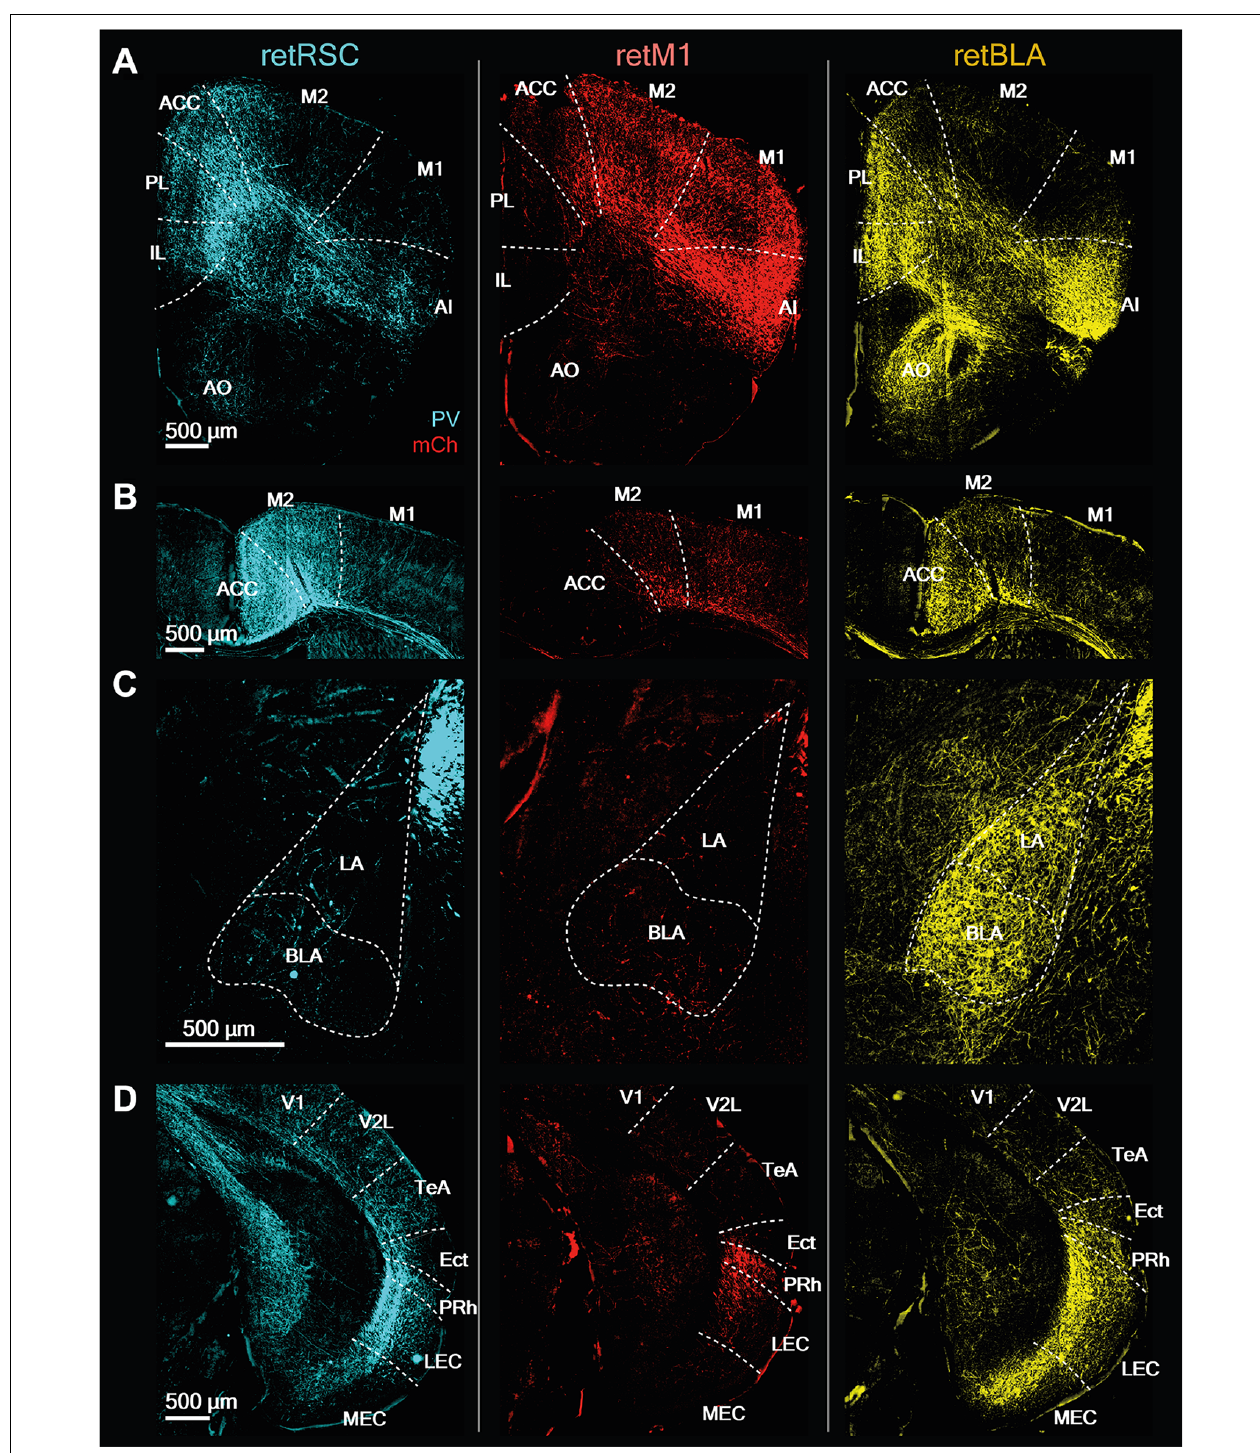
FIGURE 11 | CLA neurons projecting to RSC, BLA, and M1 have distinct innervation patterns. Representative images from prominent innervation targets illustrating the diversity of innervation of RSC-projecting (retRSC), M1-projecting (retM1), and BLA-projecting (retBLA) CLA neuron populations. Each column of images belongs to one of the three CLA projection populations: retRSC, retM1, and retBLA (right to left). (A) Anterior section. PL, Prelimbic; IL, Infralimbic; M1, M2, Primary, and secondary motor cortex; AI, Agranular insula; AO, Anterior olfactory nucleus. (B) Dorsal-midline structures. ACC, Anterior cingulate cortex. (C) Amygdala. BLA, LA, Basolateral, lateral amygdala. (D) Posterior section. V1, V2, Primary, secondary visual cortex. TeA, Temporal association cortex; Ect, Ectorhinal cortex; Prh, Perirhinal cortex; LEC, MEC, Lateral, medial entorhinal cortex.